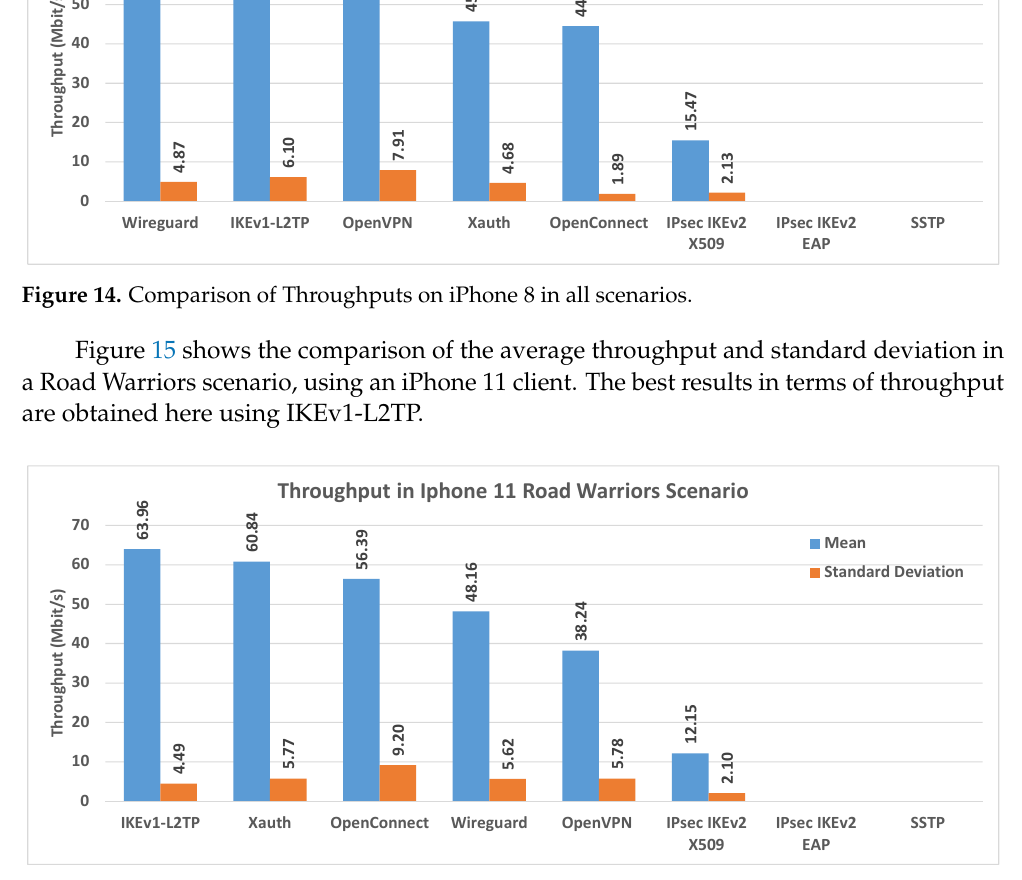
Figure 15. Comparison of Throughputs on iPhone 11 in all